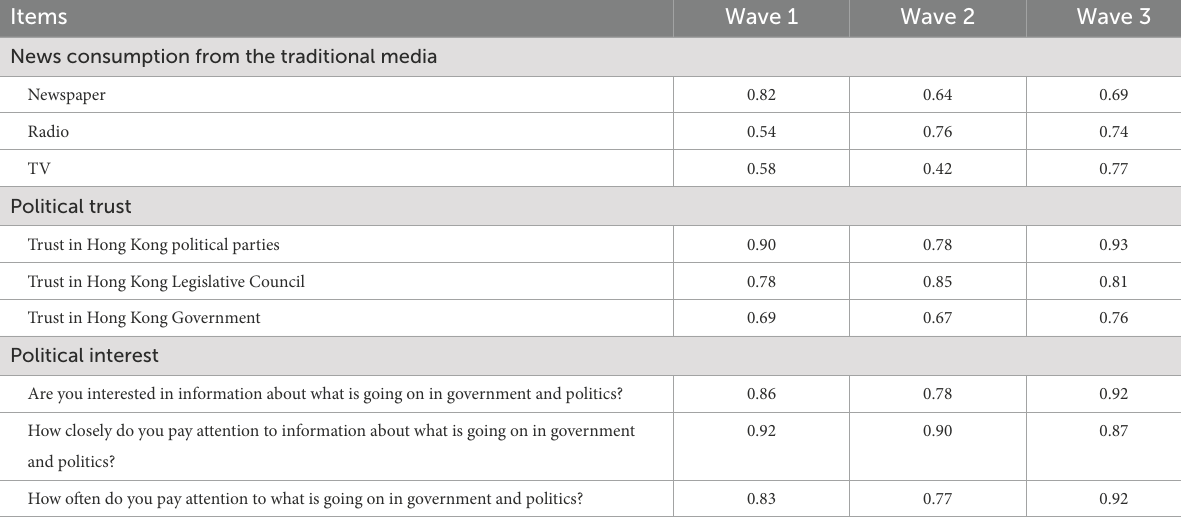
TABLE 2 Factor loadings in the measurement models ( N =